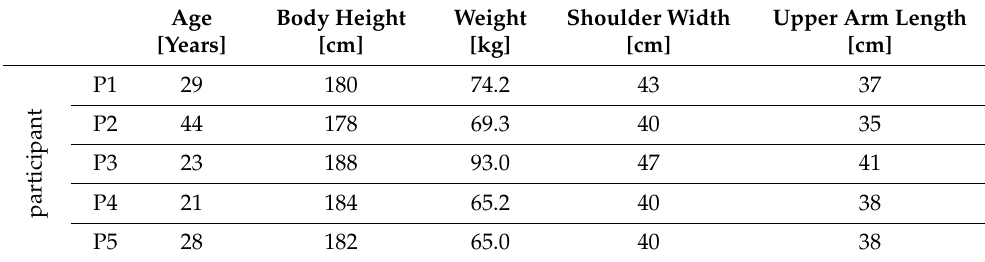
Table 1. The weight and anthropometric data of the participants.